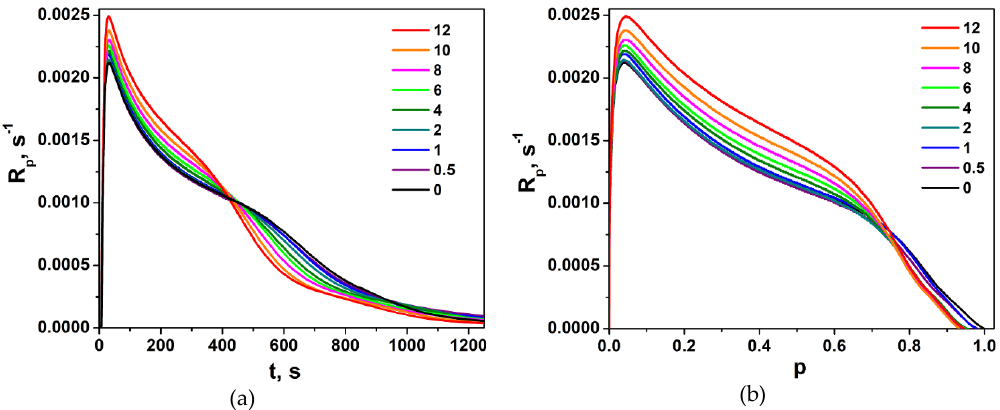
Figure 5. Polymerization rate, R p , of LM/1M-POSS compositions as a function of ( a ) the irradiation time, t , and ( b ) double bond conversion, p , at 40 °C. The numbers indicate the 1M-POSS content (mol %) in the mixture.